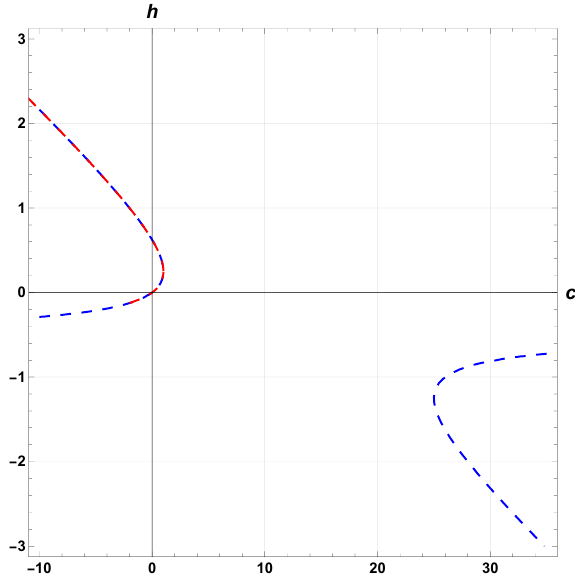
Figure 1 . Red dashed line represents the locus of ( c ( α 3 ) , h ( α 3 )) . Blue dashed line represents the locus of the level-2 Virasoro null